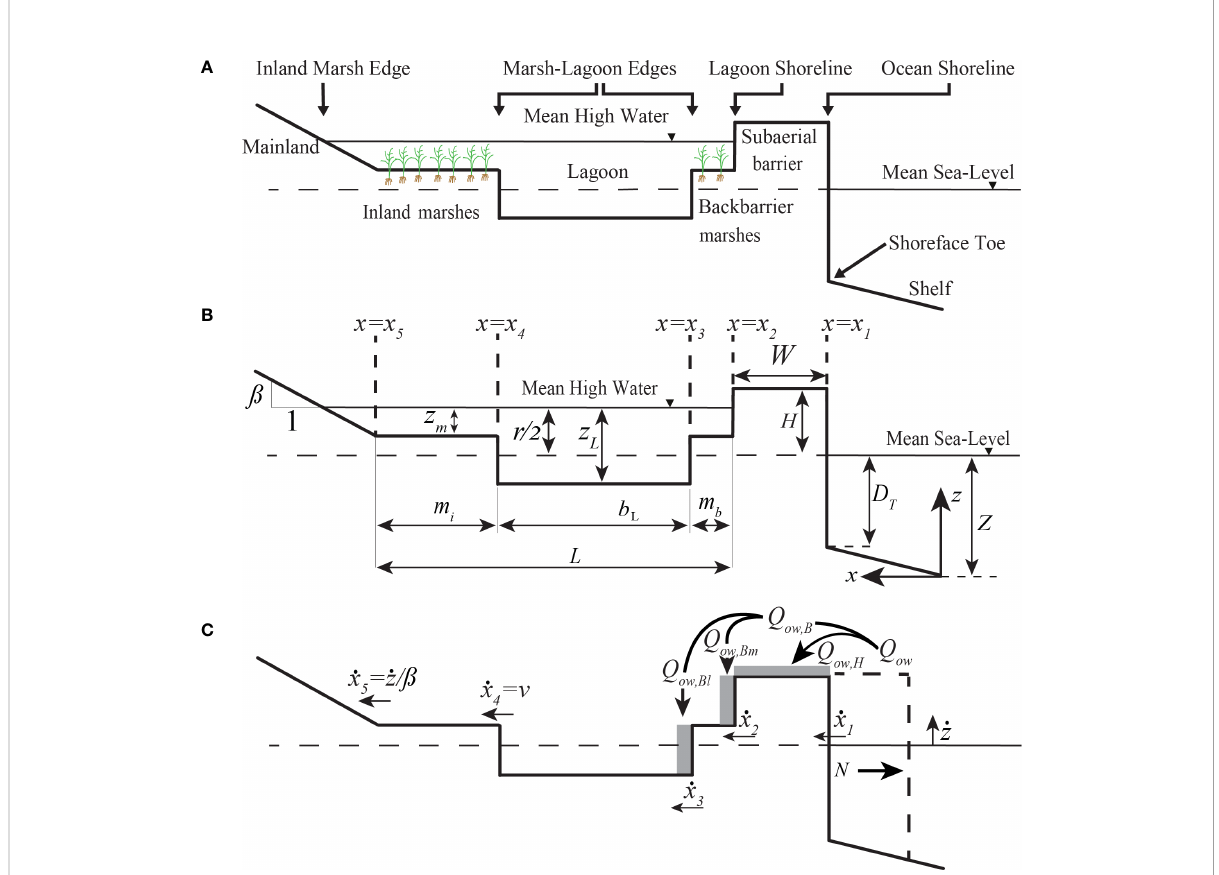
FIGURE 4 Cross-shore barrier-marsh-lagoon model set up, including (A) the different geomorphic domains and their moving boundaries, (B) state variables, and (C) the key processes that drive the evolution of the moving